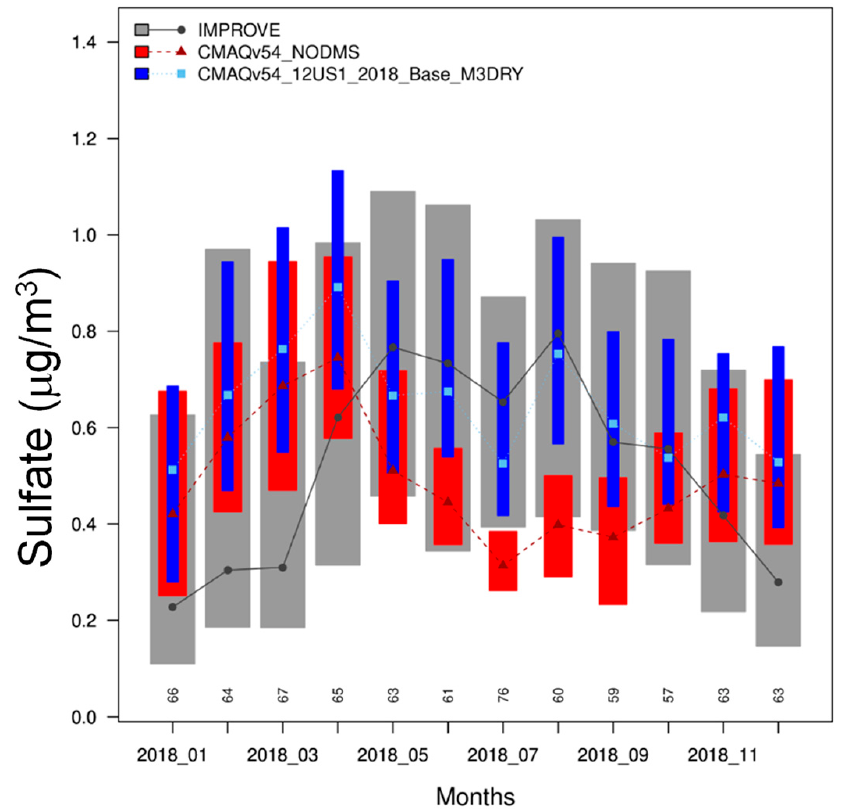
Figure 9. A comparison of model-predicted sulfate without and with DMS emissions to observed sulfate at seven coastal sites (IMPROVE sites located within 10 km of the coast) in California (PORE1, REDW1), Washington (MAKA2, OLYM1, PUSO1), and Florida (CHAS1, SAMA1). Boxplot of observed sulfate (grey boxes and lines); model without DMS emissions (red boxes and lines); and model with DMS emissions (blue boxes and lines) by month. The shaded box represents the interquartile range (25% to 75%) of the data and the point indicates the median value. The numbers below each box indicate the total number of observations available for that month.